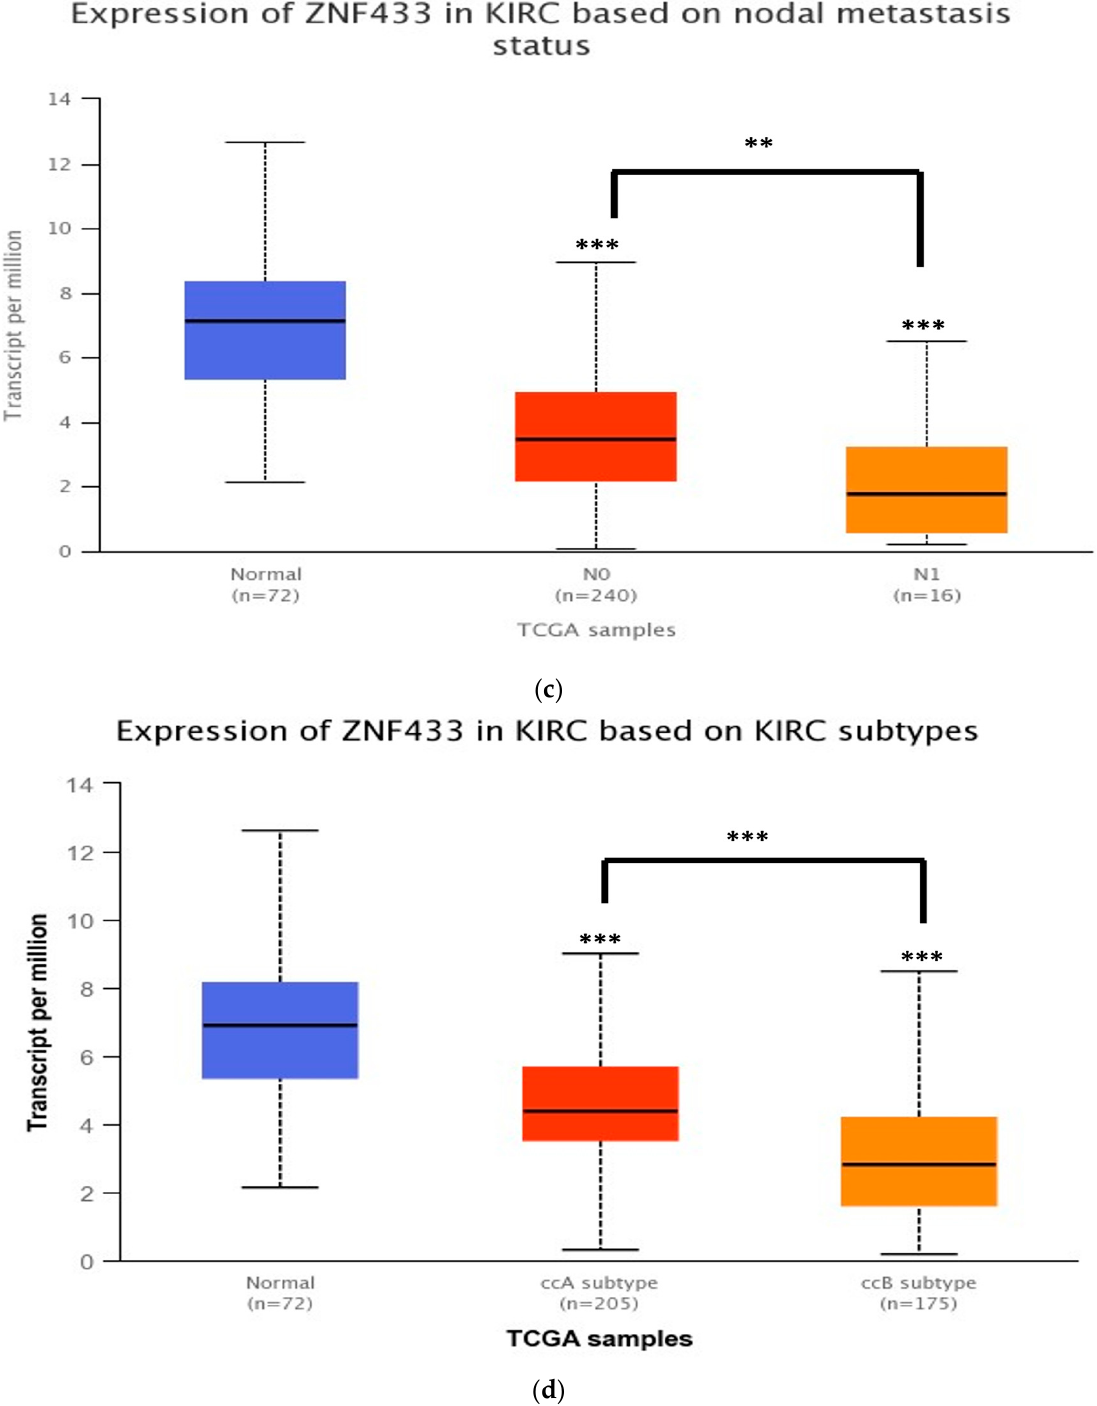
Figure 2. ( a ) Expression of ZNF433 transcripts across cancer stages in clear-cell renal cell carcinoma. ZNF433 transcripts were significantly downregulated in all tumor stages relative to normal tissues. ( b ) Expression of ZNF433 transcripts across histological grades of clear-cell renal carcinoma. ZNF433 transcripts were significantly downregulated in all tumor grades relative to normal tissues. ( c ) Expression of ZNF433 transcripts in metastatic tissues. ZNF433 transcripts were decreased with greater nodal involvement ( p < 0.01). ( d ) Expression of ZNF433 transcripts in clear-cell renal cell carcinoma subtypes. ZNF433 transcripts were reduced in both subtypes, with ccB ccRCC exhibiting the lowest expression ( p < 0.001). All plots were generated using UALCAN analysis of RNAseq data using TCGA datasets. ** p < 0.01 and *** p < 0.001